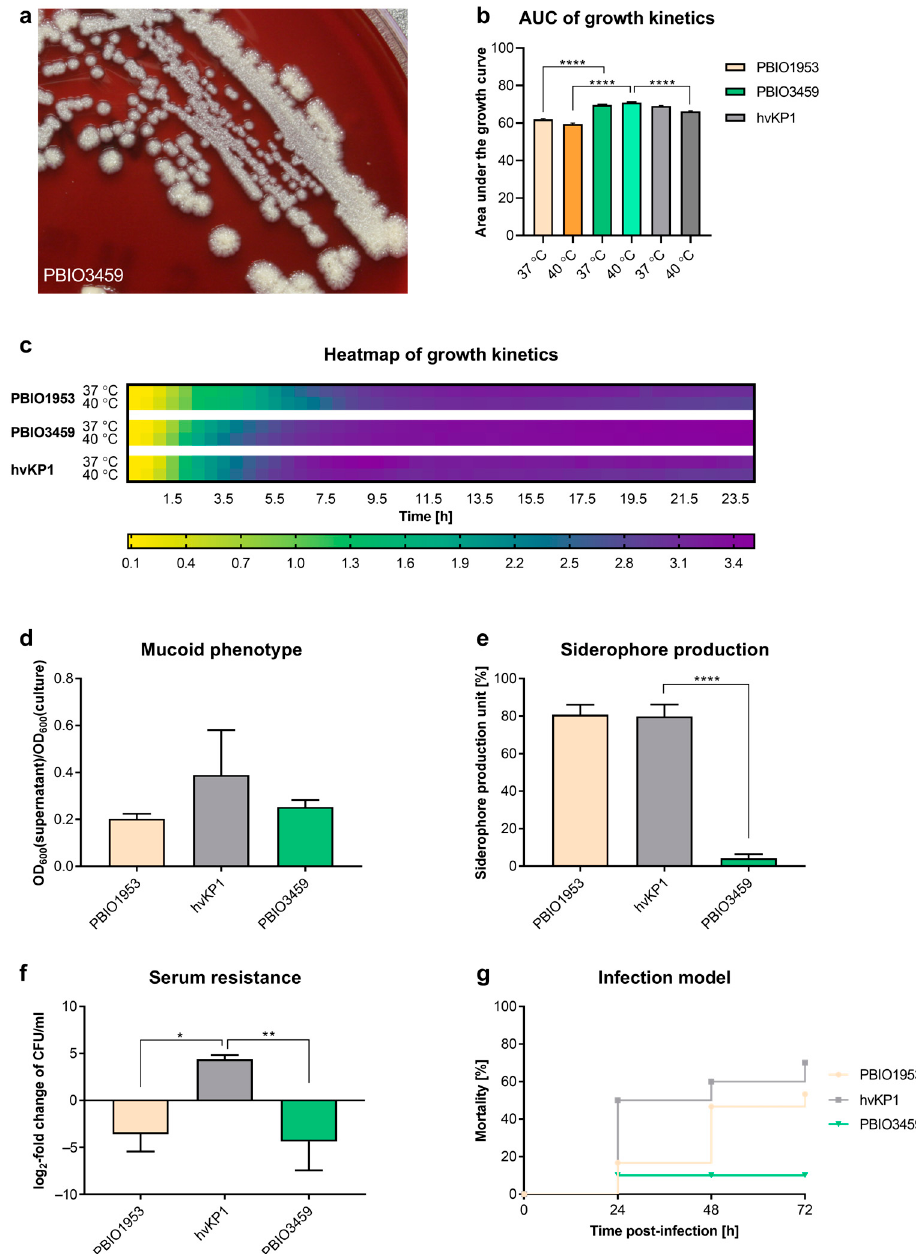
Figure 1. Phenotypic virulence-associated features of PBIO3459. ( a ) PBIO3459 on blood agar with sponge-like colonies. ( b , c ) Heatmap of growth kinetics in LB at different temperatures and corresponding area under the growth curve (AUC) ( n = 3). The results are given as mean values with standard deviation. ( d ) Determination of the mucoid phenotype using a sedimentation assay ( n = 3). The results are given as mean ratios of OD 600 of supernatant after centrifugation at 1000 × g for 5 min and total OD 600 and standard deviation. ( e ) Siderophore production of the respective isolates, shown as siderophore production unit (spu) and standard deviation ( n = 3). ( f ) Survival in 50% human serum after 4 h of incubation. Results are given as mean values and standard deviation of log 2 fold change of CFU/mL ( n = 3). ( g ) Kaplan–Meier plot of mortality rates in the Galleria mellonella larvae infection model ( n = 3). Results are given as mean mortality after injection of 2 × 10 5 CFU. Statistical significance was tested with one-way ANOVA and (for ( g )) two-way ANOVA (with Dunnett’s multiple comparison post hoc test); * p < 0.05, ** p < 0.01, **** p <